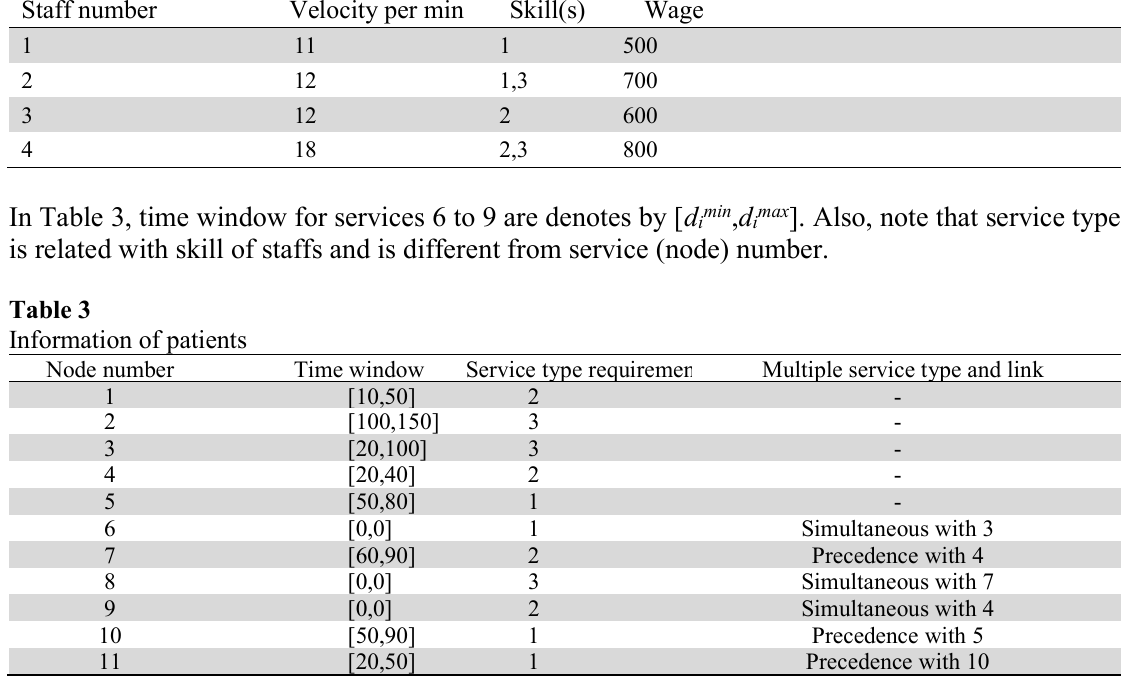
Precedence with 10